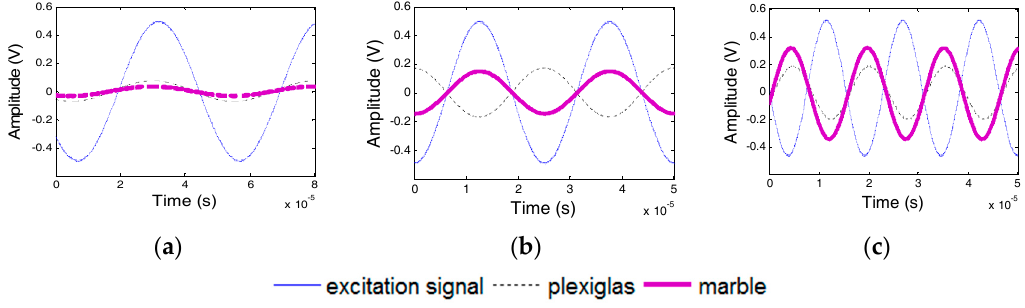
Figure 18. PZT transducer signal of Specimen 2. ( a ) 20 kHz Excitation Frequency; ( b ) 40 kHz Excitation Frequency; and, ( c ) 60 kHz Excitation Frequency.